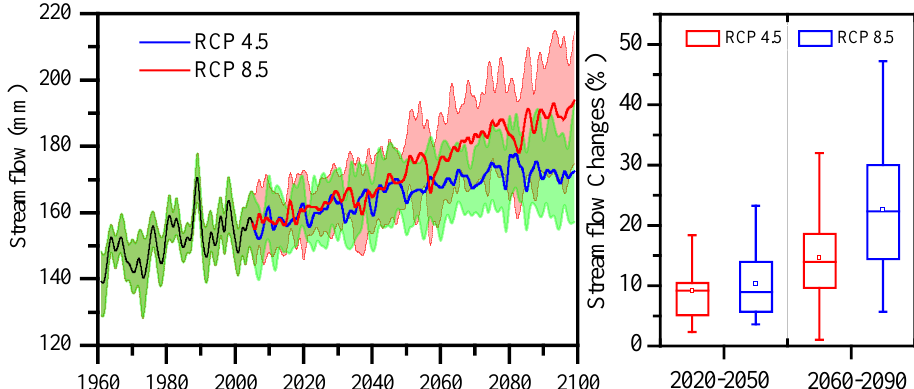
Figure 9. Annual streamflow variation under future climate change scenarios in the upper watershed of the Heihe River. The shadows and solid lines of the left panel represent the 90% predictive uncertainty and average value, respectively. In the box plot (right panel), the dot represents the average value, the upper and lower hinges represent the 75th and 25th percentiles, respectively. The whiskers show the other data points, except for the outliers. The line within the box shows the median.